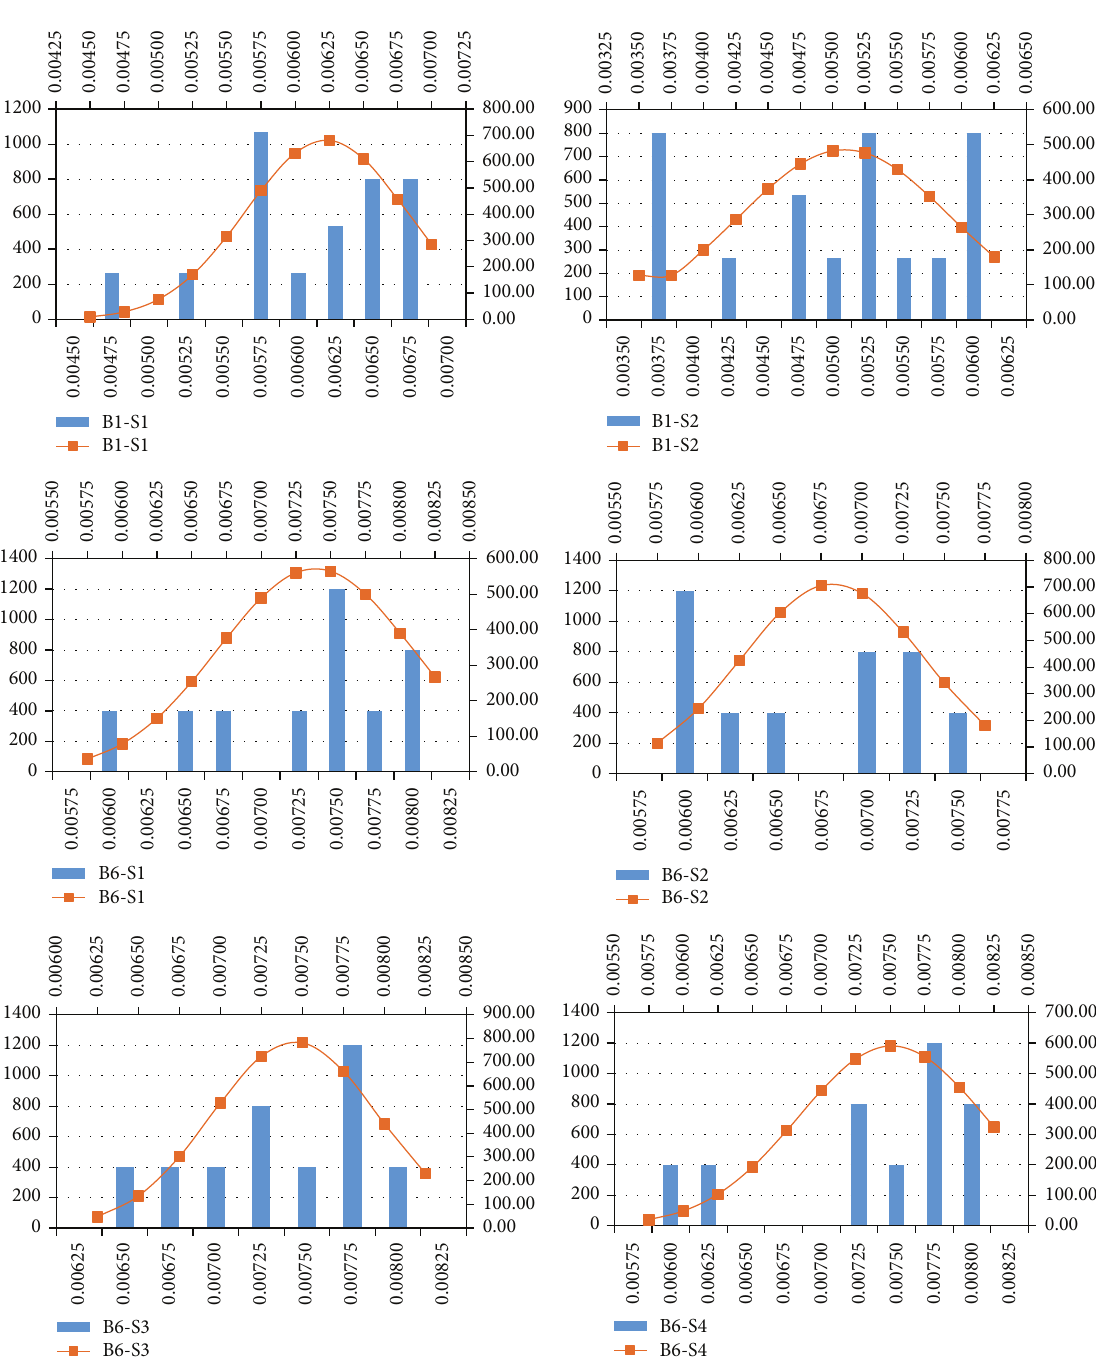
Figure 8: Probability of occurrence and density functions of bars’ diameters: